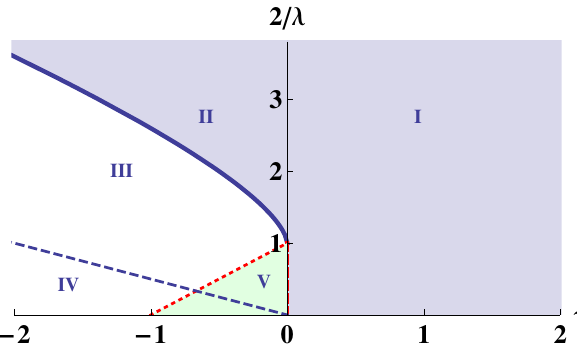
Figure 2 . Partial representation of the phases of the theory in the region (cid:21) > 0. The one-cut solution (3.6) exists in the shaded regions I and II. In region IV the minimum of the potential at (cid:11) = 0 has disappeared. The ungapped solution (3.14) exists in region V. It matches continuously on the red dashed vertical line with the solution at (cid:28) (cid:21)